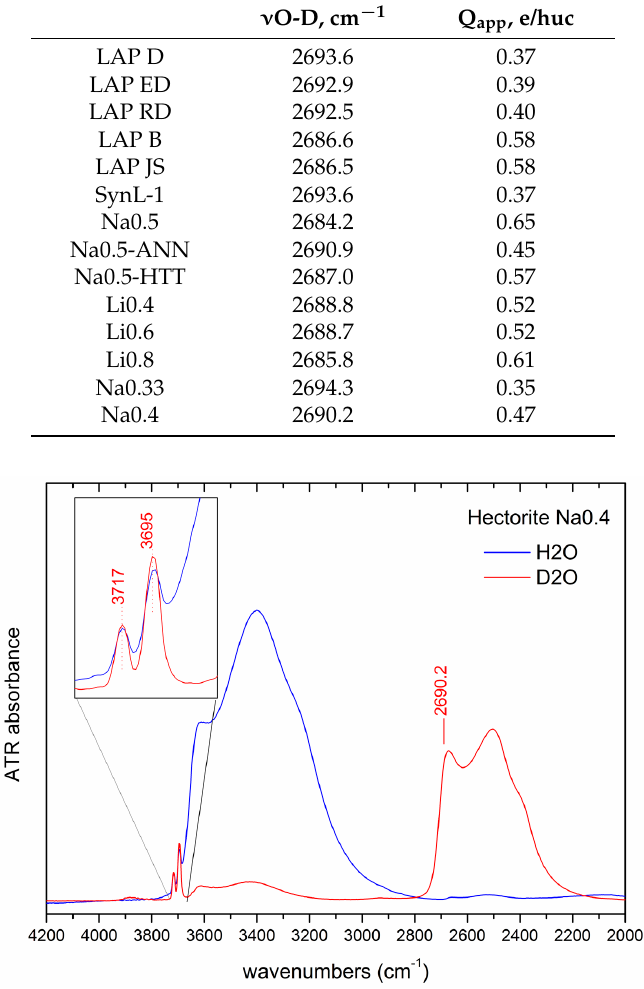
Figure 7. Detail of the ATR spectra of the synthetic hectorite Na0.4, fully hydrated in H 2 O (blue) and D 2 O (red). The ν O-D mode at ~2690 cm − 1 is